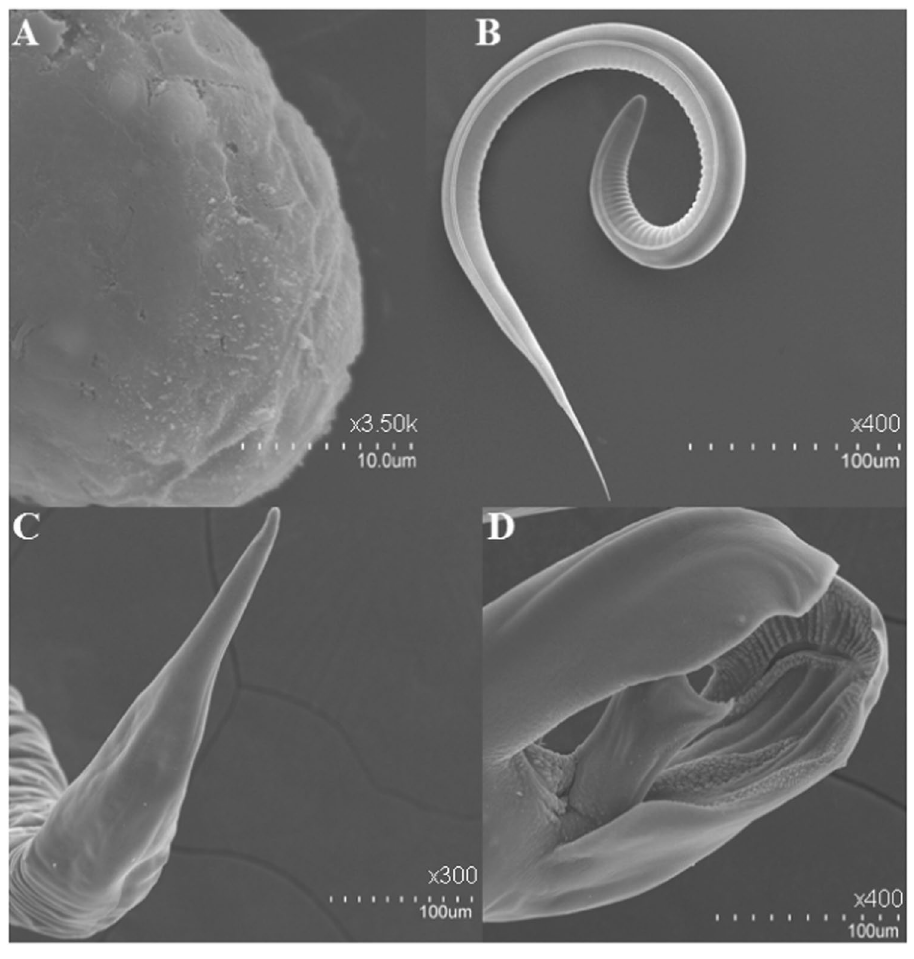
Figure 1. Transmission electron microscope (TEM) images of the different life -cycle stages of H. contortus . ( A ) H. contortus egg. ( B ) H. contortus larva. ( C ) H. contortus adult female worm (posterior end). ( D ) H. contortus adult male worm (posterior end).